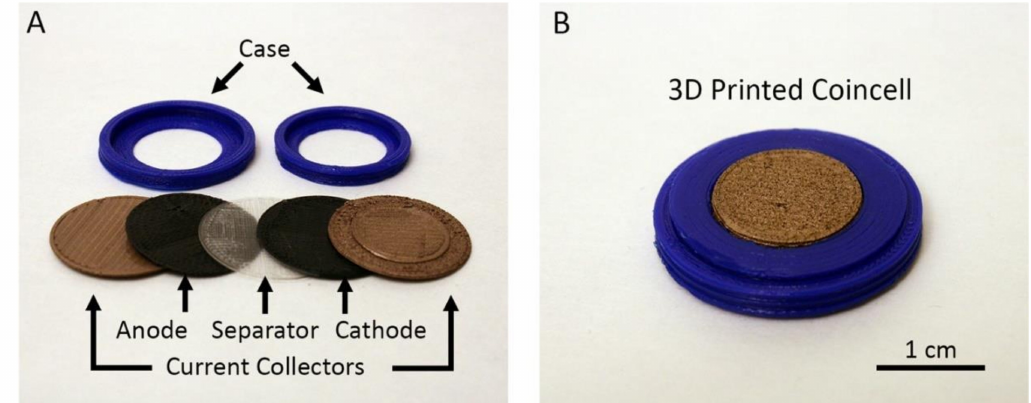
Figure 18. ( A ) Individual components of the 3D-printed coin cell. ( B ) Assembled 3D-printed coin cell (Reproduced with permission from Reference [163], copyright 2018, American Chemical Society).